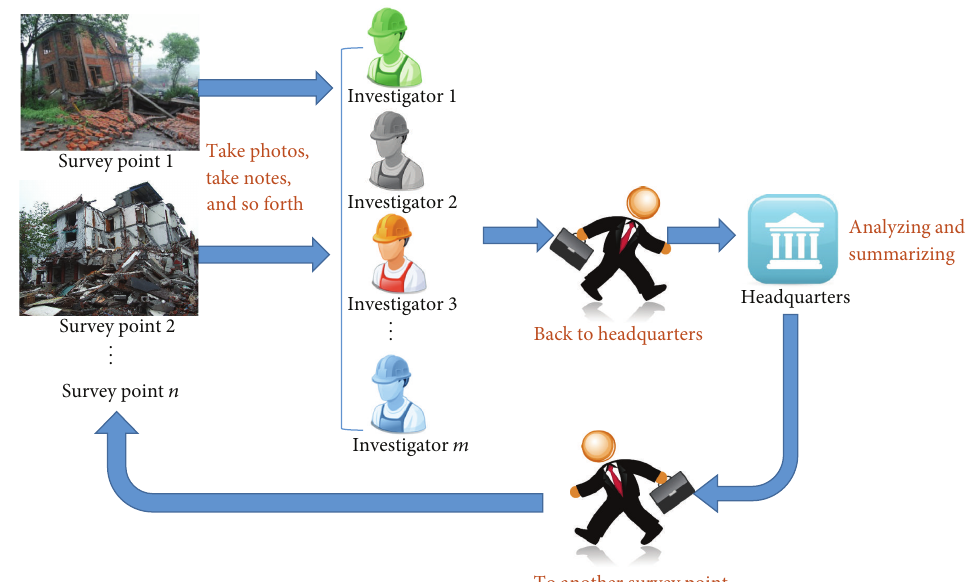
Figure 13: Traditional seismic damage investigation method.